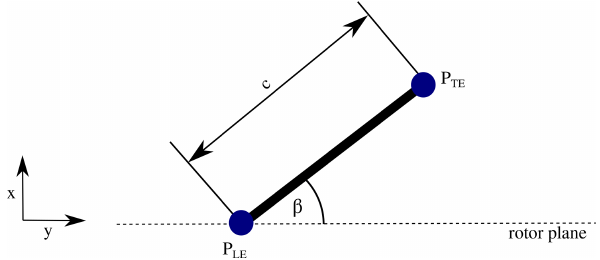
Figure 12. Determination of the pitch + torsion angle β out of DIC measurements. c : chord length of the rotor blade; x : OoP position; y : IP